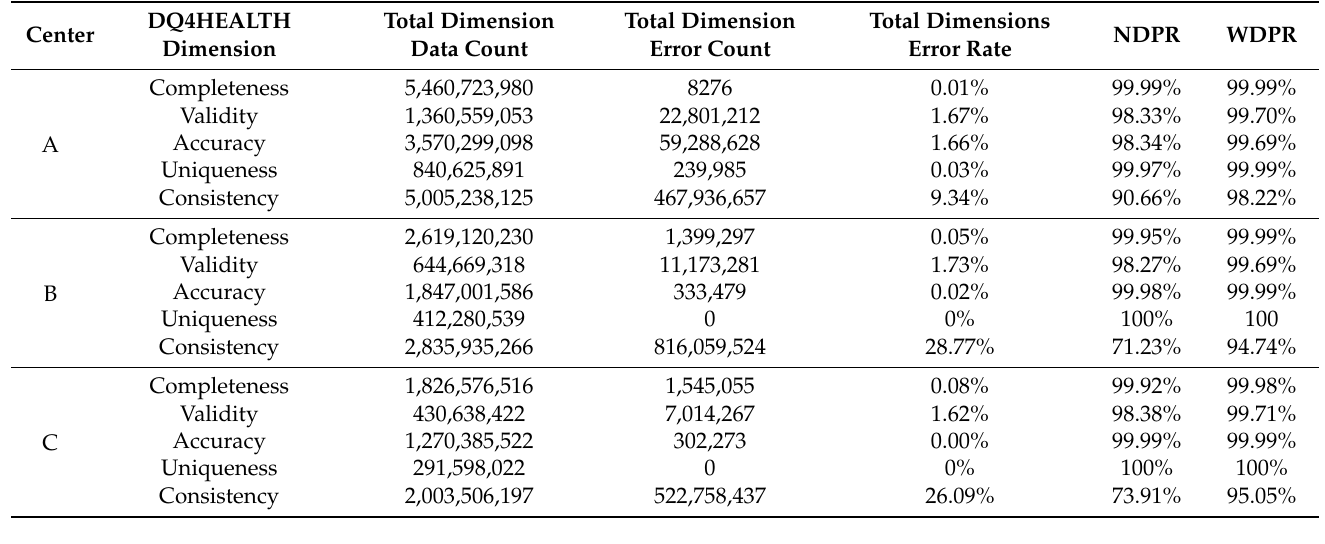
Table 5. Multicenter OMOP CDM data quality assessment specific results.